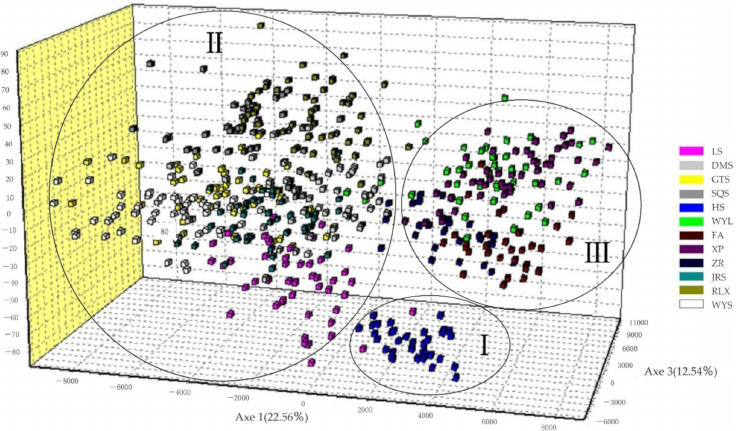
Figure 2. Factorial correspondence analysis of the C. chekiangoleosa population. Axes 1, 2, and 3 explain 22.56, 16.96, and 12.54% of the genetic variation, respectively.